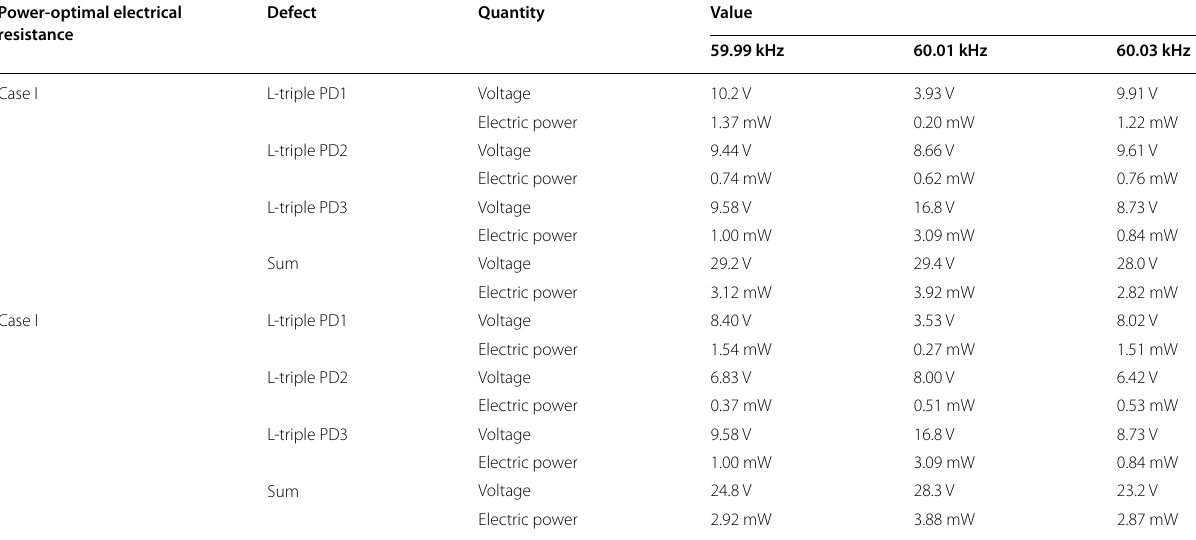
Table 3 Output voltage and electric power values at peak frequencies and their sums across the power‑optimal electrical resistances Power-optimal electrical